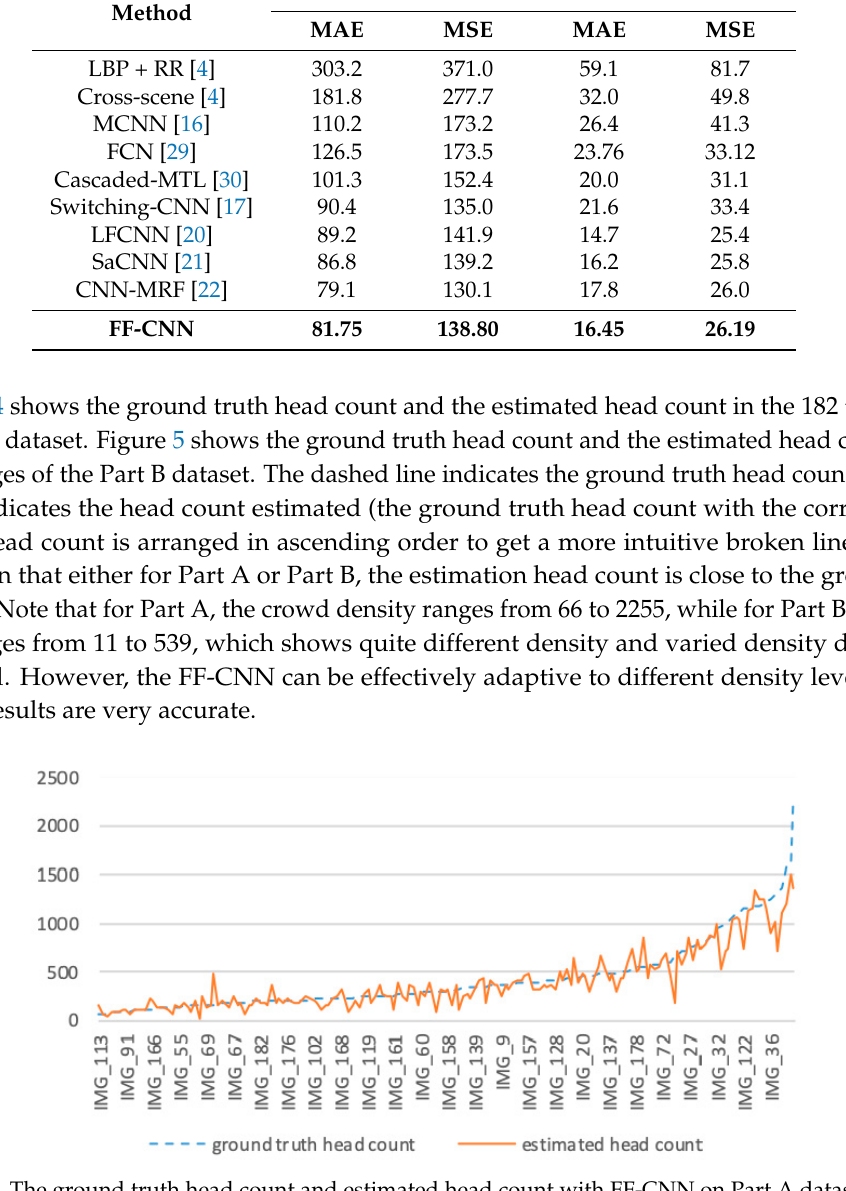
Table 2. Experimental results on ShanghaiTech dataset with different methods.